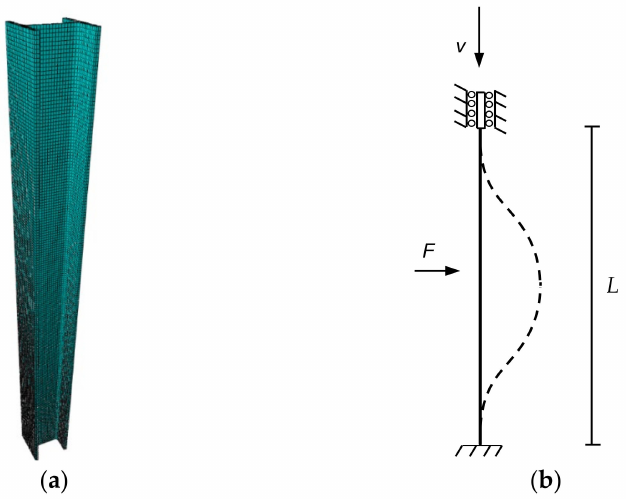
Figure 6. Specimen mesh and idealization: ( a ) Mesh for 5 m long specimen and mechanical slender- ness of 49.4. ( b ) Boundary conditions, load, and displacement applied to the